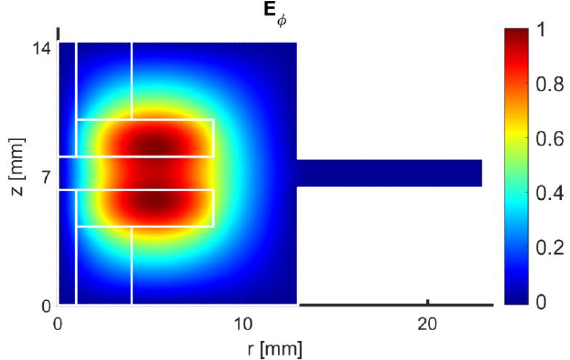
Figure 2. Normalized 𝐸 𝜙 component of the fundamental mode of the considered SPDR without any sample (air) is obtained from FD-FEM solver.